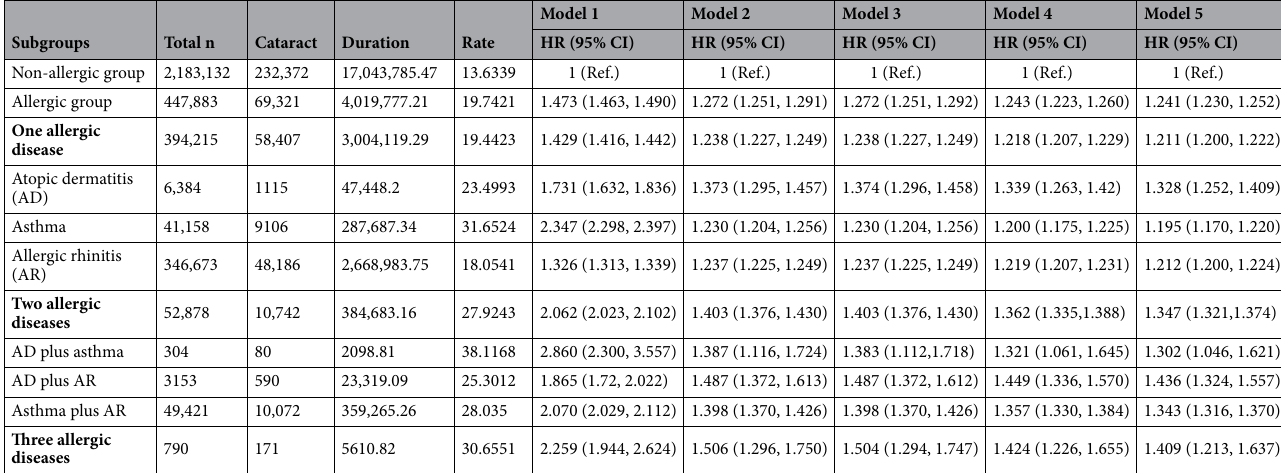
Table 2. Risk for cataract development according to presence of allergic diseases. CI, confidence interval; HR, hazard ratio. Model 1 non-adjusted. Model 2 is adjusted for age, sex. Model 3 is adjusted for age, sex, smoke, drink, regular exercise, and low income. Model 4 is adjusted for age, sex, smoking, drinking, regular exercise, low income, diabetes mellitus (DM), hypertension, dyslipidemia, chronic kidney disease (CKD), and body mass index (BMI). Model 5 is adjusted for age, sex, smoking, drinking, regular exercise, low income, DM, hypertension, dyslipidemia, CKD, BMI, glaucoma, and retinal vascular occlusion.